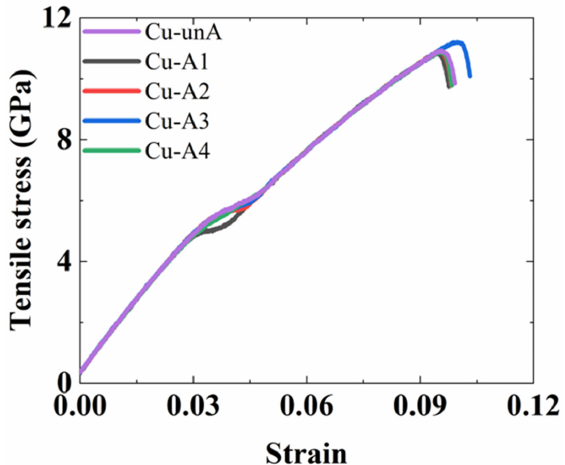
Figure 13. The tensile stress–strain curves of the Cu–Al 4 Cu 9 structures before annealing and at different temperatures of annealing.